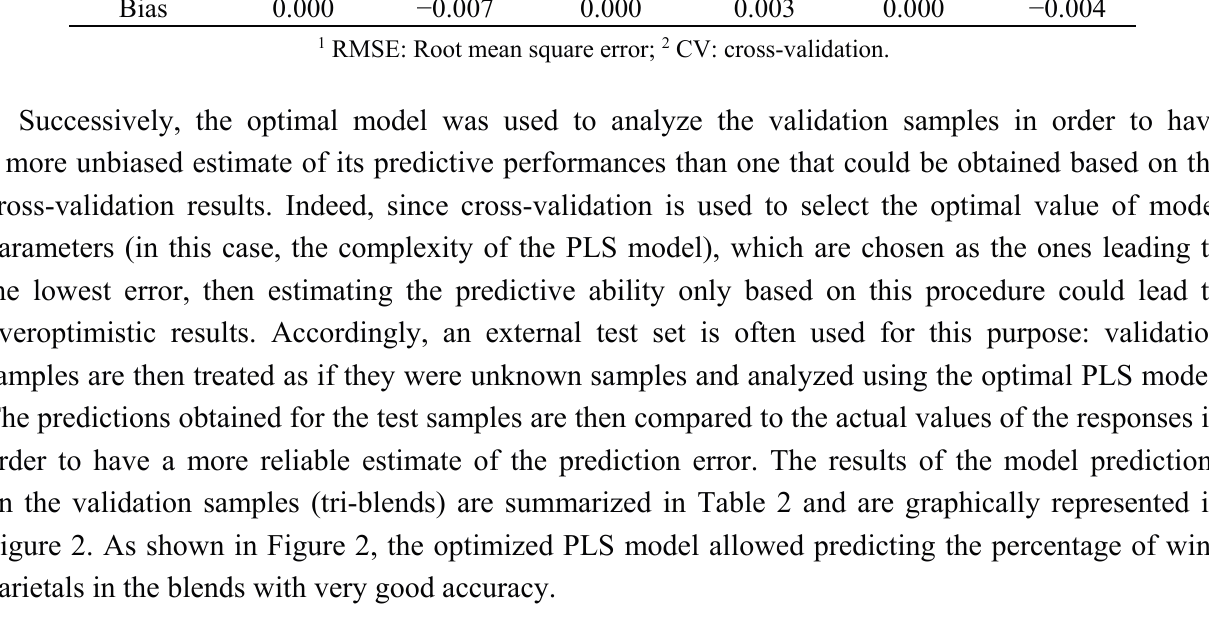
Table 2. Model performances in predicting the percentage of wine varietals in tri-blends.